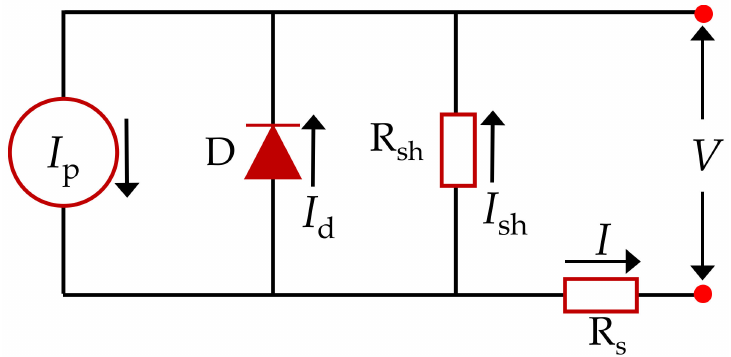
Figure 4. SDM equivalent circuit of standard PV